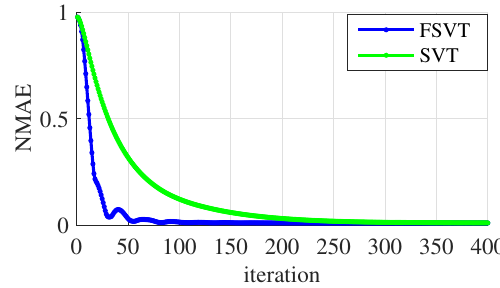
Figure 11. NMAE over iteration time between FSVT and